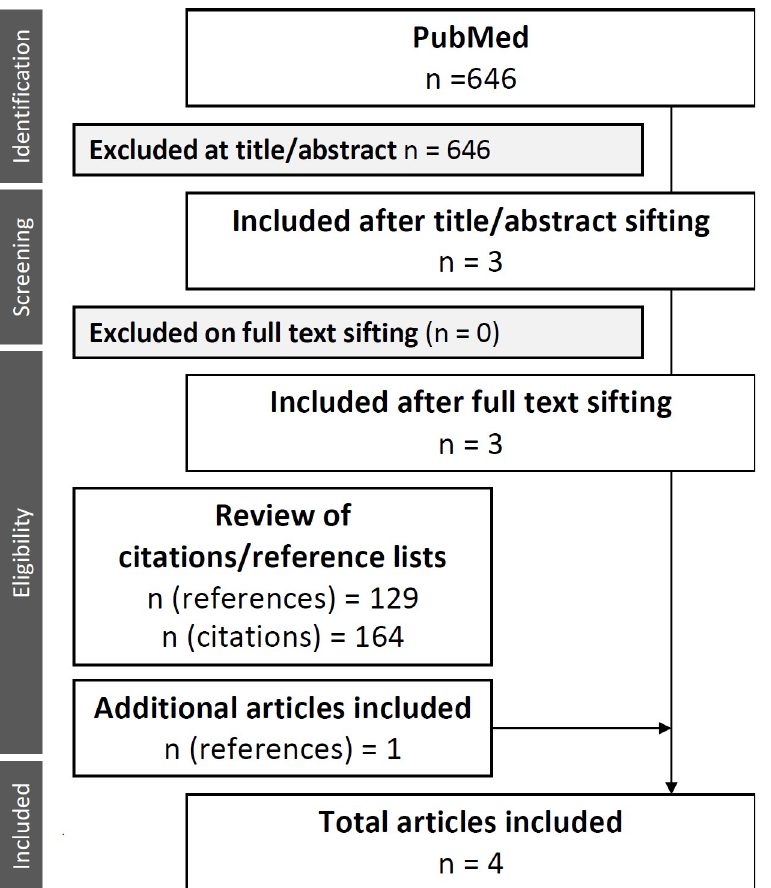
Fig 6. Flow diagram showing process of identification of animal studies for review. n, number of studies.